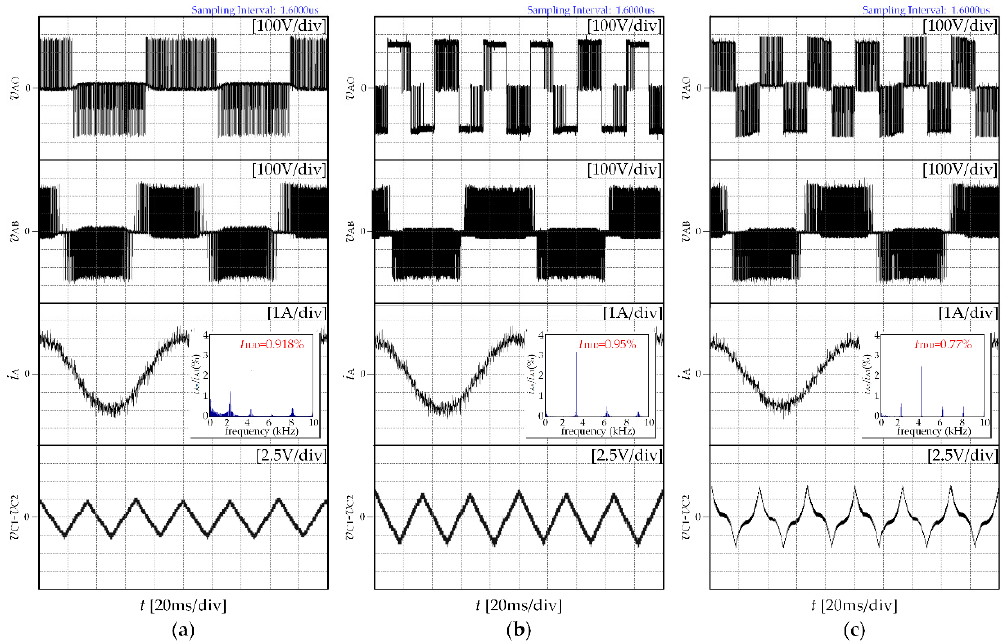
Figure 9. Experimental results for CPWM, DPWM3, and the proposed strategy when m = 0.2: ( a ) CPWM; ( b ) DPWM3; ( c ) the proposed strategy.